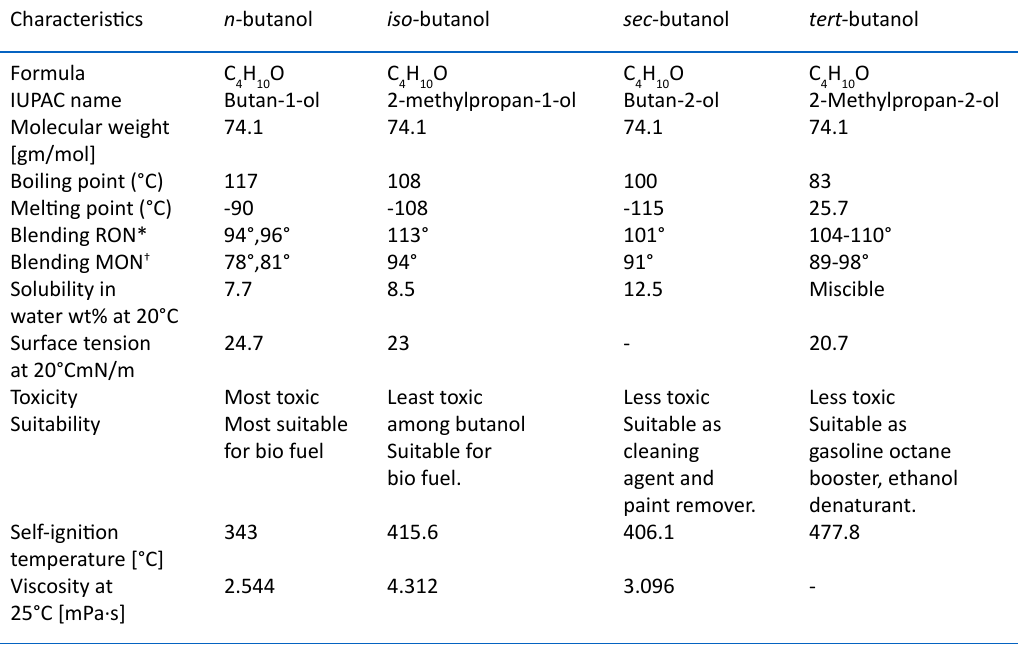
table 1. Physiochemical properties of different isomers of butanol Characteristics n- butanol